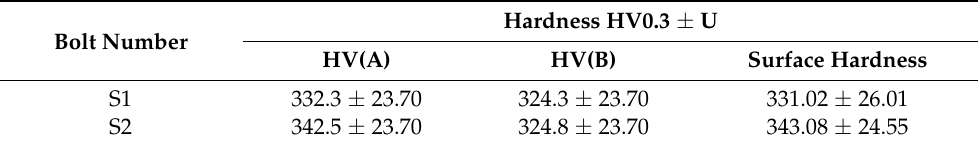
Table 3. Results of the HV0.3 microhardness measurements at the longitudinal sections of the threads and at the head surfaces of the bolts.